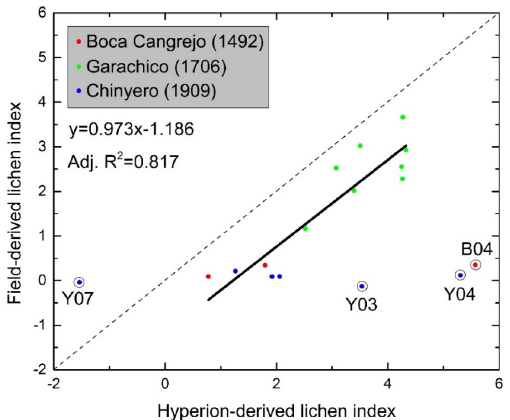
Figure 12. Comparison between Hyperion-derived lichen index and field-derived lichen index ( p ref 1660 ´ ref 1725 q{p ref 1660 ` ref 1725 q ). The linear regression model was defined without the four outliers indicated by black circles. The grey dashed line is the 1:1 line. As lichen presence was very limited on the Boca Cangrejo and Chinyero lava flows due to their younger age, or higher elevations and/or drier climate than the Chahorra, the mapping of lichen coverage using Hyperion was applied to the Garachico flow only. In order to minimize non-lichen effects, vegetated and urbanized areas on the Garachico lava flow were excluded. For comparison, the lichen coverage was modelled and mapped from the Hyperion image using a calibrated lichen index (Figure 13d) based on the relationship between field